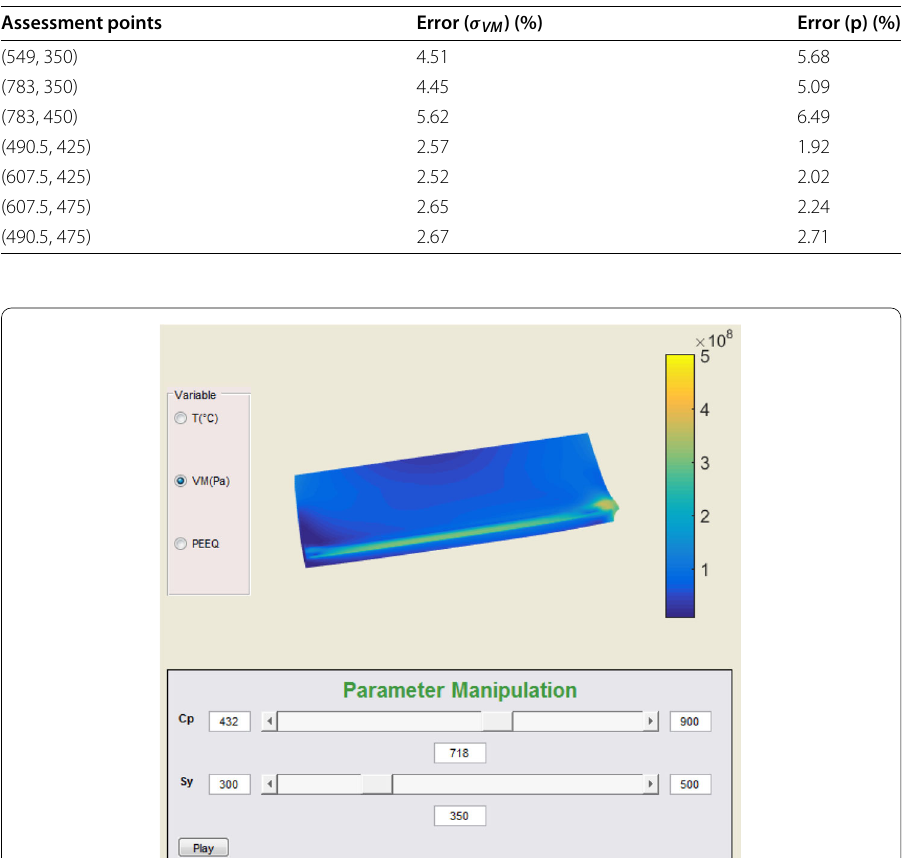
vademecum (Fig. 15) is thus constructed. Only two refinements are needed to satisfy the error condition. Limited memory is required for storing the RB snapshots. Parametric space–time solutions can be provided by the 2D interpolation in real time (see Table